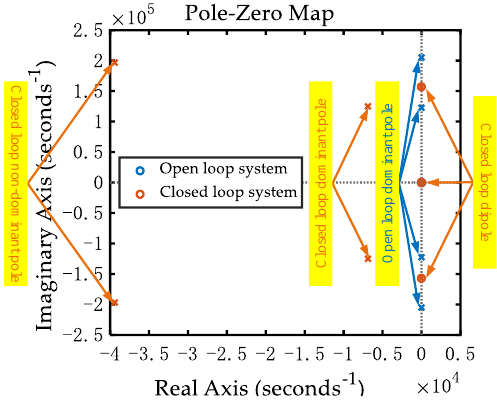
Figure 13. Pole-zero map of LCLC resonant inverter.